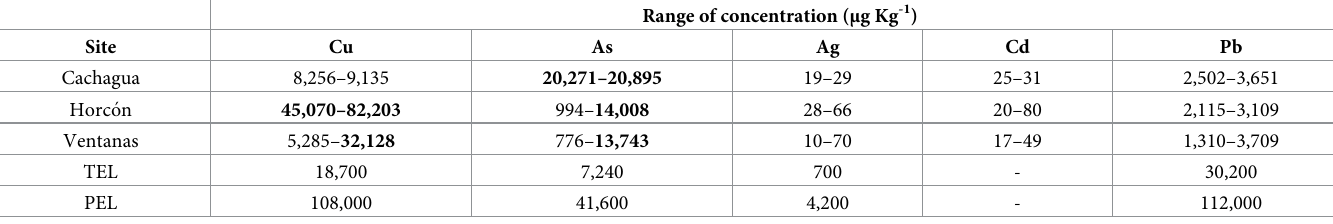
Table 2. Range of concentrations of heavy metals in marine sediments from Cachagua, Horco´n and Ventanas (2018).